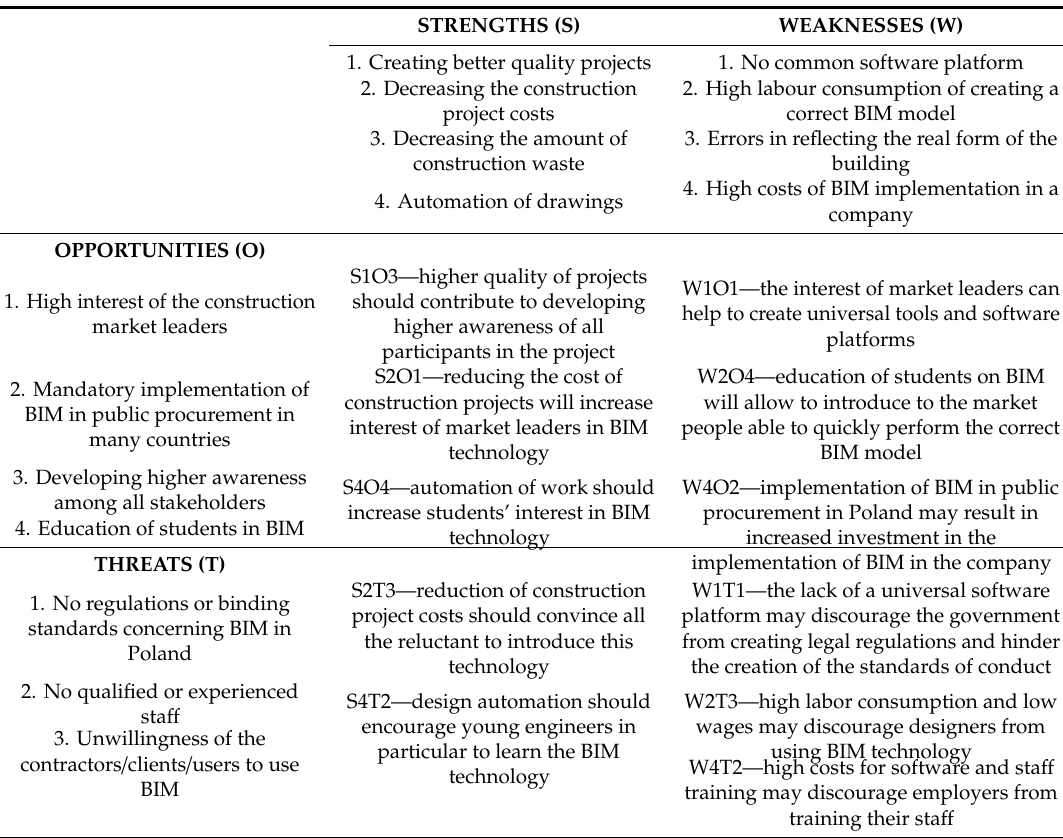
Table 5. Matrix of strategic tasks and